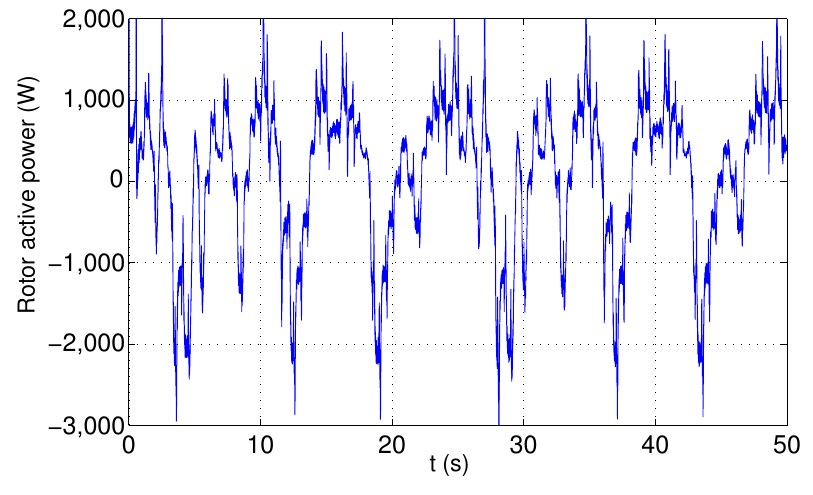
Figure 12. Rotor active power for the wind profile of Figure